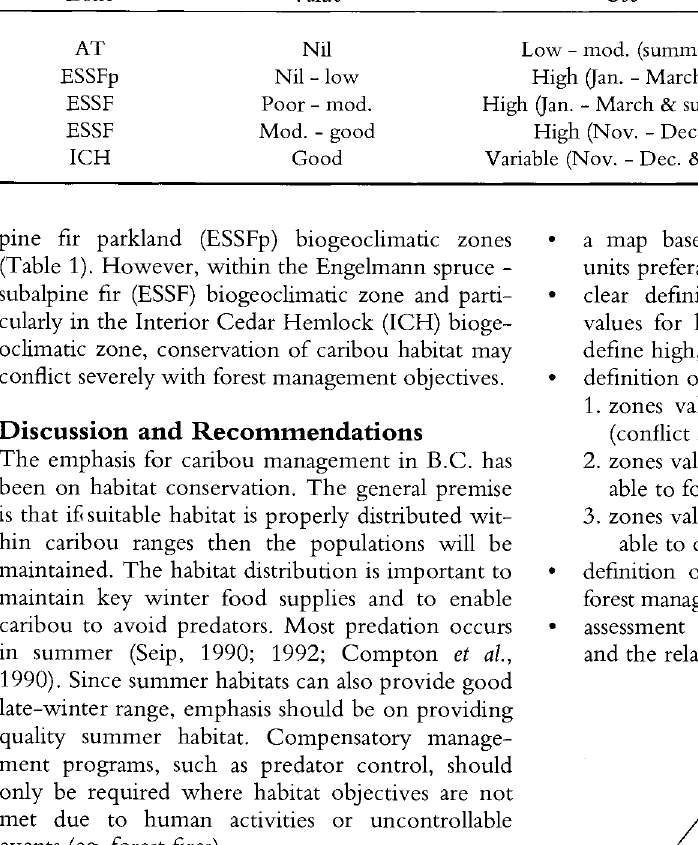
Table 1. Caribou use and forest values in different elevation bands and biogeoclimatic zones.